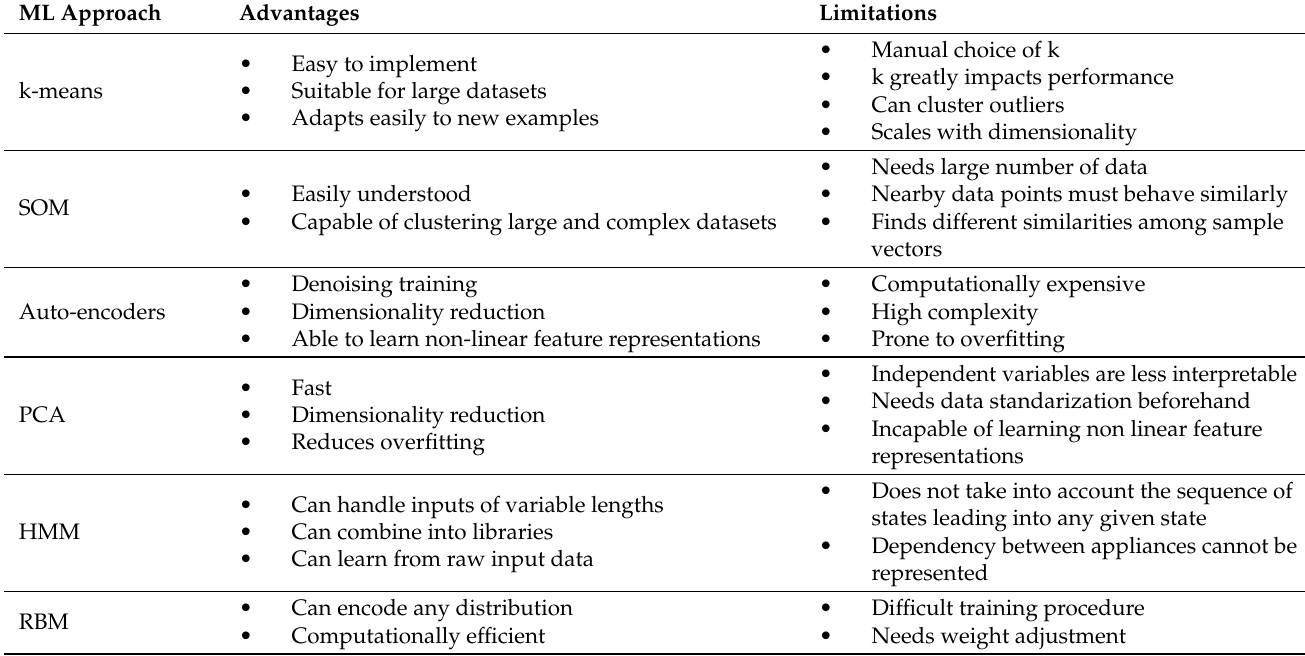
Table 3. Advantages and limitations of unsupervised ML